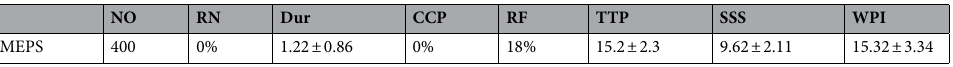
Table 3. Different Criteria Domains in MEPS study group. RN rheumatoid nodules, Dur duration, CCP anti-CCP, RF rheumatoid factor, TTP tender trigger points, SSS symptom severity score, WPI widespread pain